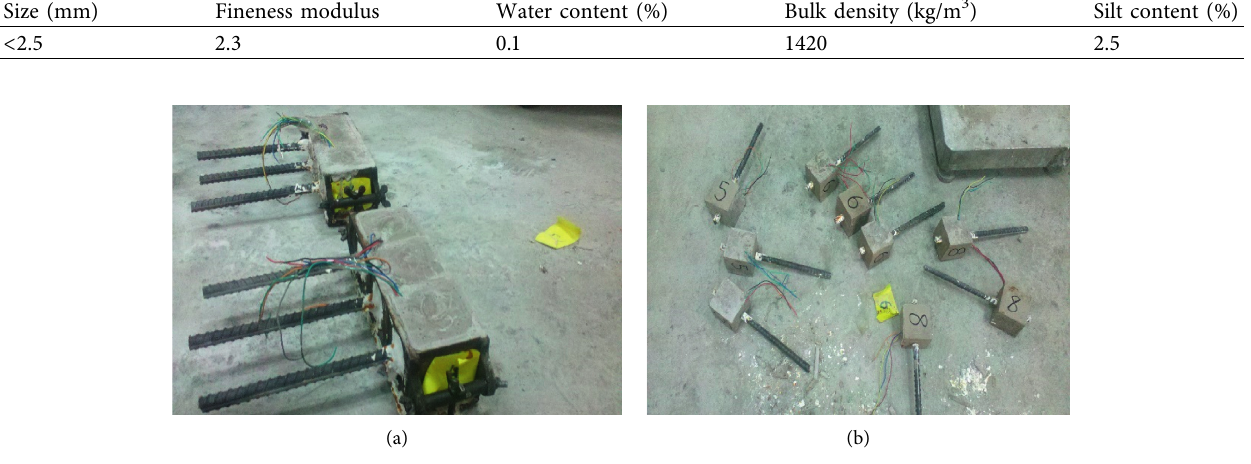
Figure 1: Mortar specimens with different sizes: (a) SP-L; (b) SP-S.